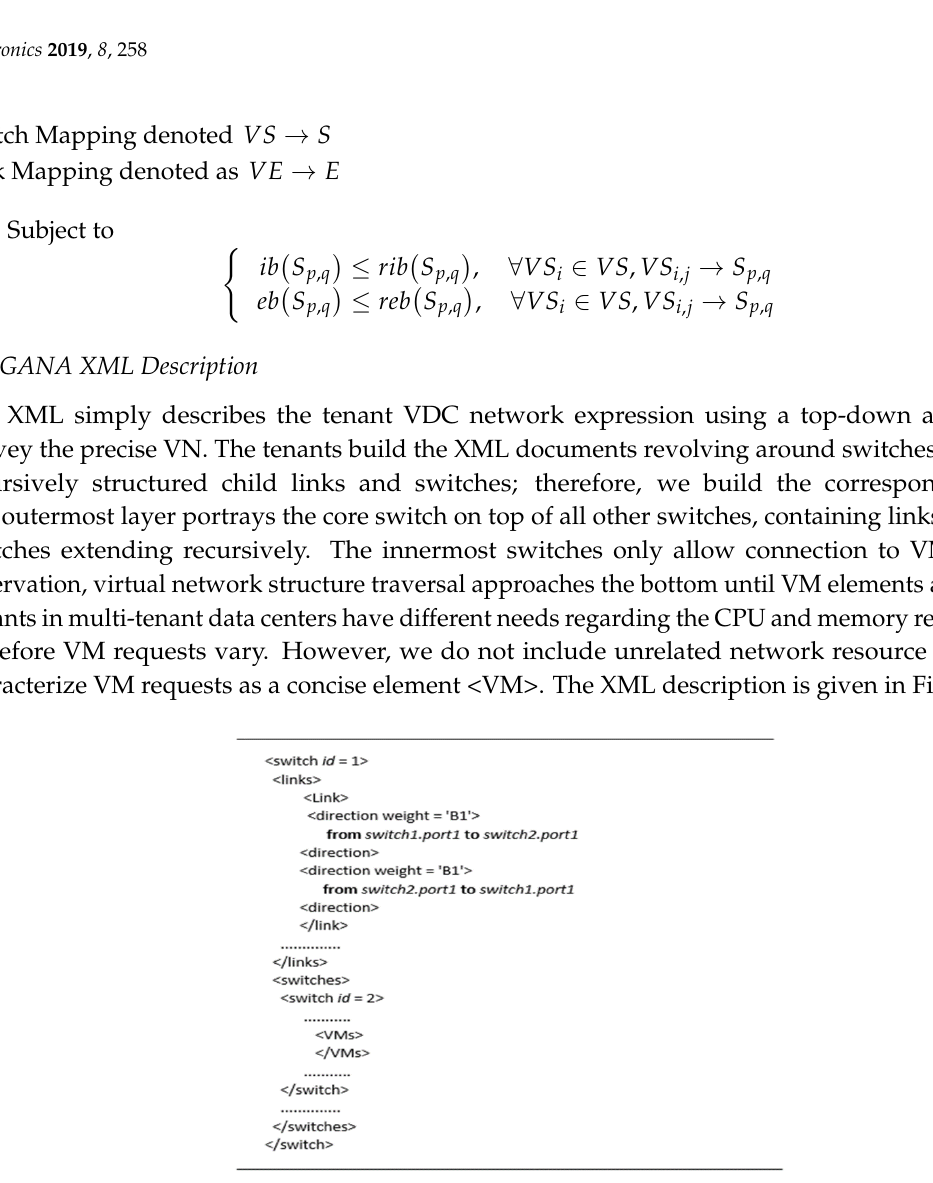
Figure 3. GANA Switch-Centered VN to PN mapping.